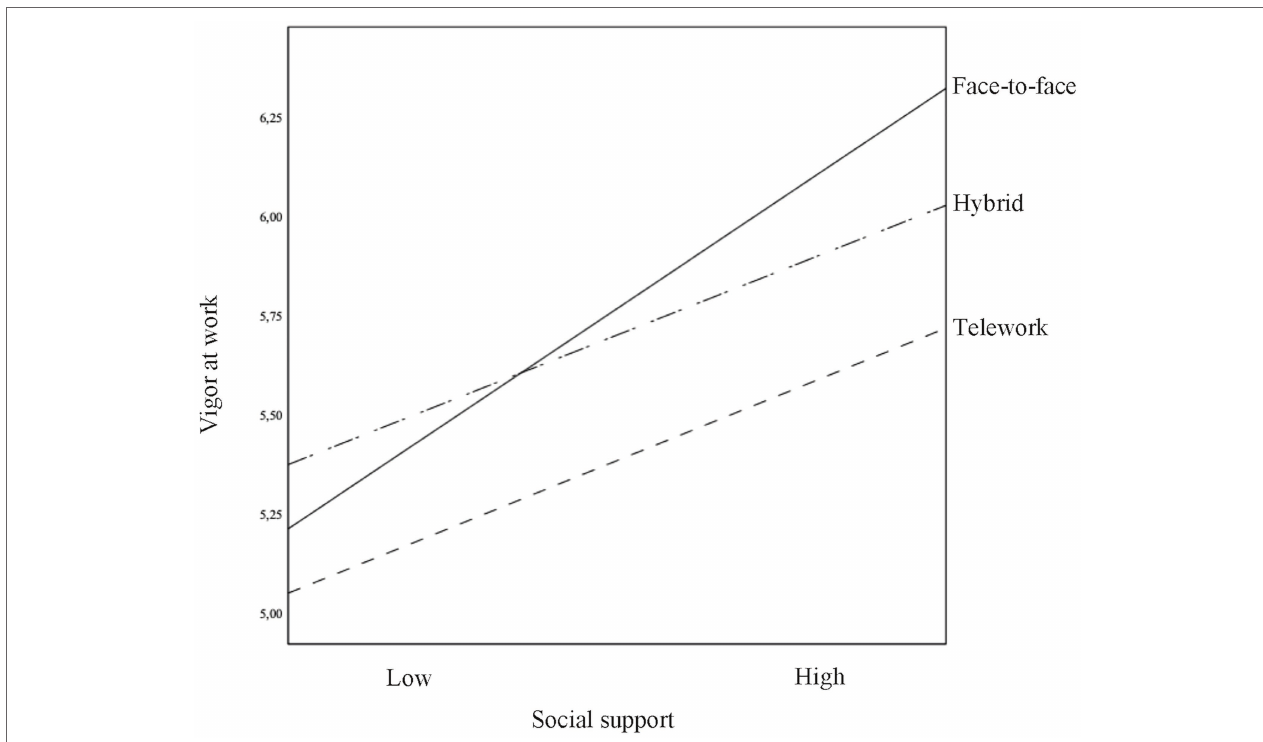
FIGURE 1 | Regression lines showing the effects of the interaction between work modality and social support in the prediction of levels of vigor at work. High and low social support values represent 1 SD above and below the average of the